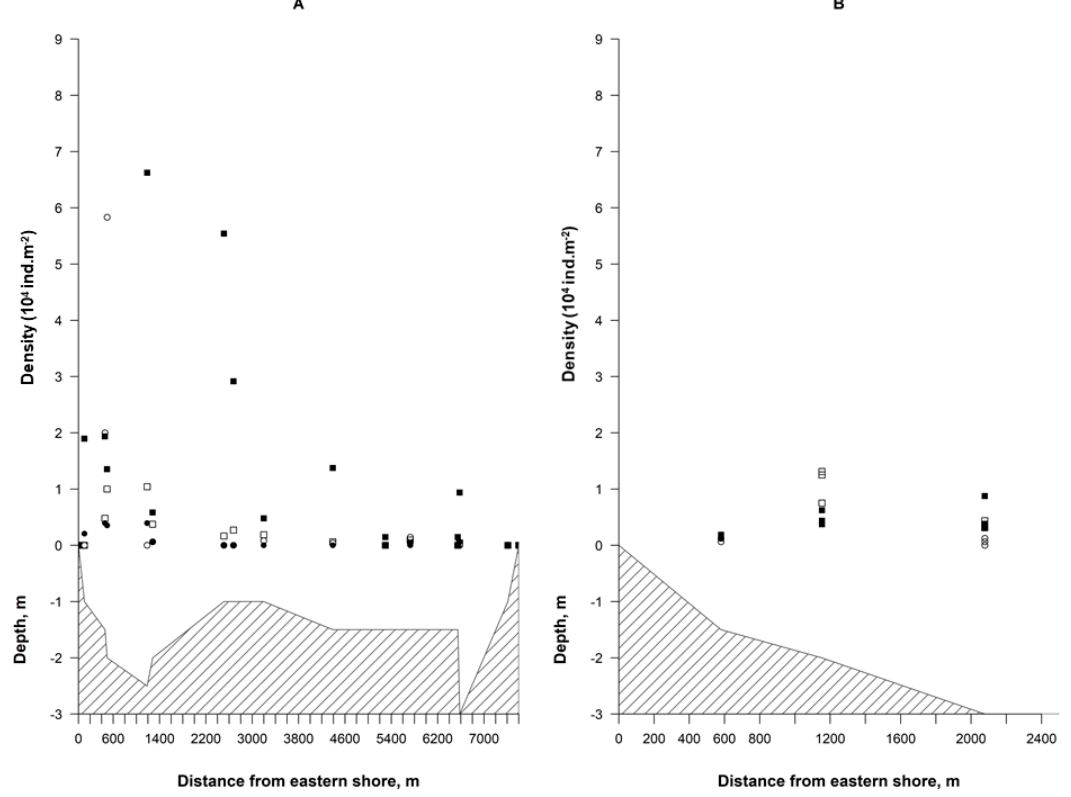
Figure 4. The distribution of the density of charophyte fructifications in the most representative profiles (third and sixth) of the first cluster ( A ) and the second cluster ( B ) during the period of 2017–2019. Full circles—full oospores, empty circles—full gyrogonites, full squares—empty oospores, and empty squares—empty gyrogonites.